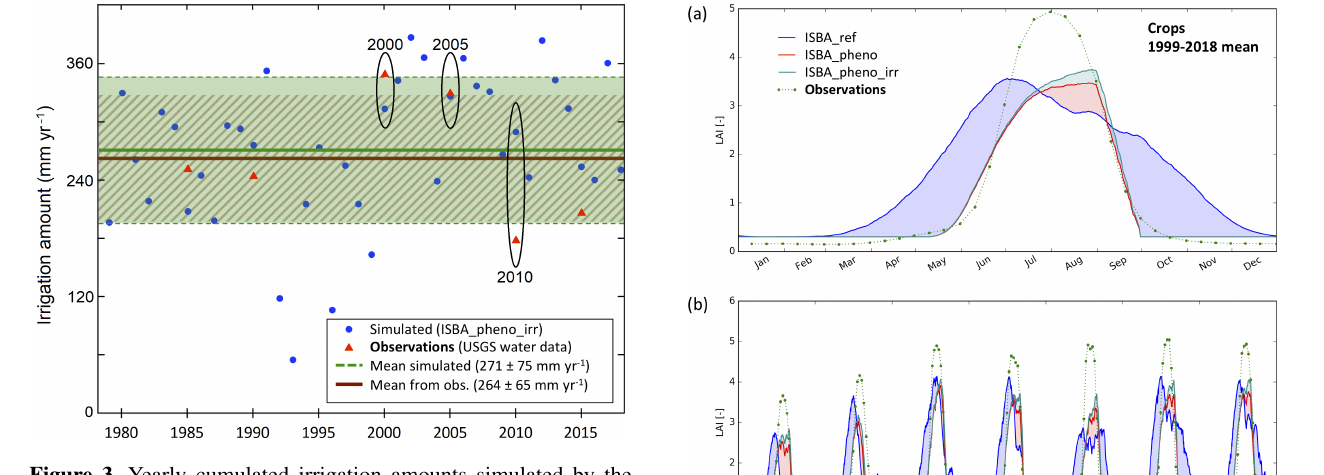
Figure 3. Yearly cumulated irrigation amounts simulated by the model for the studied area in Nebraska from 1979 to 2018 (blue dots). The six USGS observations from 1985 to 2015 are shown (red triangles). The mean and standard deviation of the yearly val- ues are shown for the model (green solid and dashed lines, respec- tively) and for the USGS data (brown lines). The 2000 and 2005 dry years are indicated, together with the 2010 wet year.